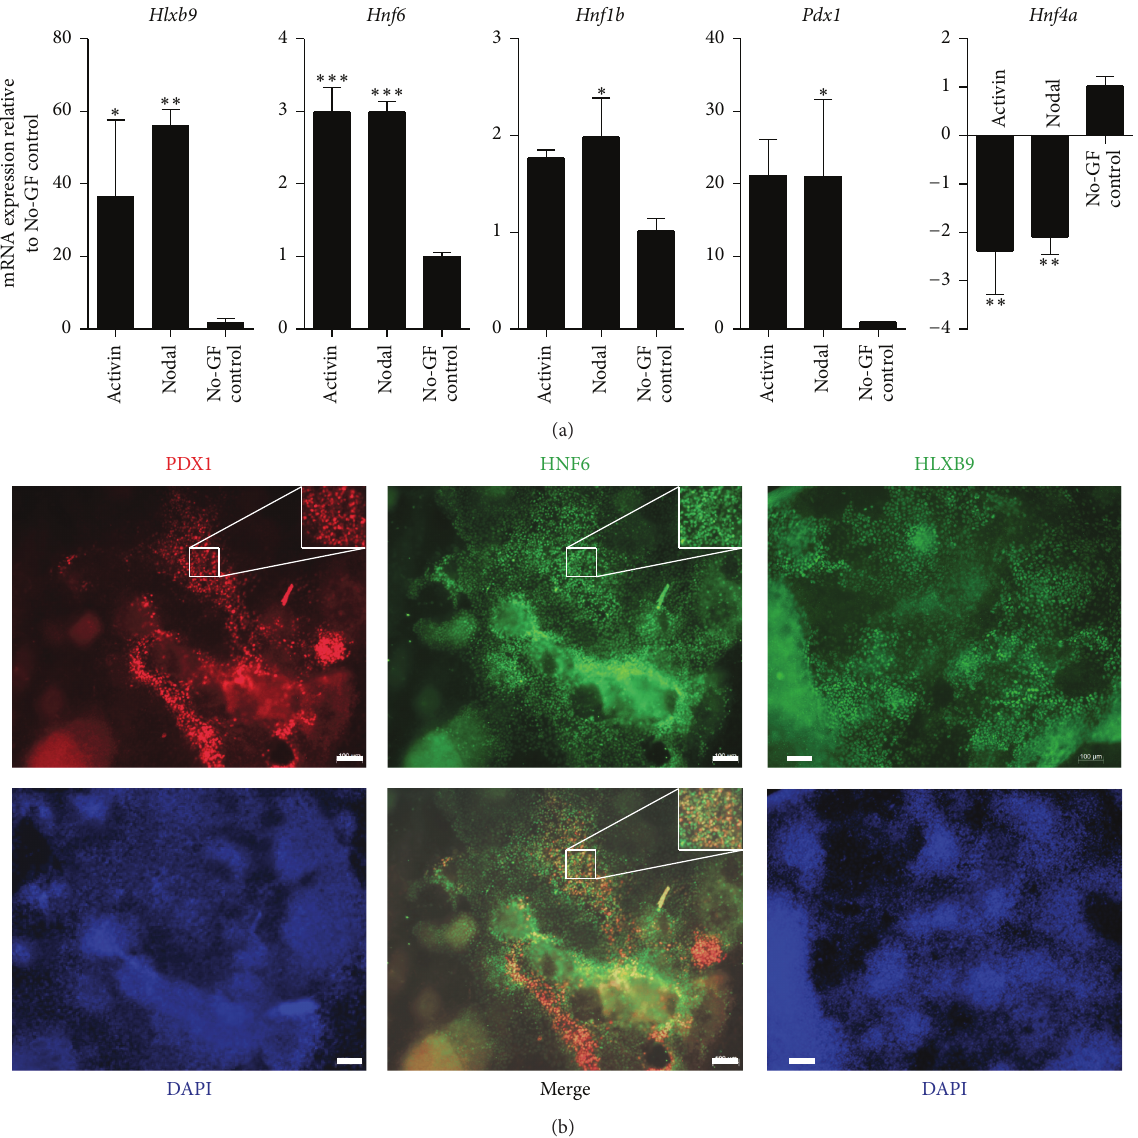
Figure 3: Analysis of mESC-derived posterior foregut endoderm. (a) Posterior foregut endoderm markers, Hlxb9 , Hnf6 , Hnf1b , and Pdx1 , were significantly higher in Nodal- and Activin-derived cultures than in no growth factor treated (No-GF) control cultures. On the other hand, Hnf4a that is expressed in liver progenitors was reduced. 𝑁 = 2 -3. Data are presented as mean ± SEM. Asterisks indicate 𝑃 values on comparison with No-GF control cultures: ∗ 𝑃 < 0.05 , ∗∗ 𝑃 < 0.01 , and ∗∗∗ 𝑃 < 0.001 determined by one-way ANOVA with Tukey’s multiple comparison test. (b) Immunofluorescent staining of Nodal-derived posterior foregut endoderm cultures indicates the expression of the above-mentioned markers at the single-cell protein level. Pdx1 is expressed in Hnf6-expressing cells. Scale bars, 100 𝜇 m. Sst , and exocrine digestive enzyme, Amy2a , were